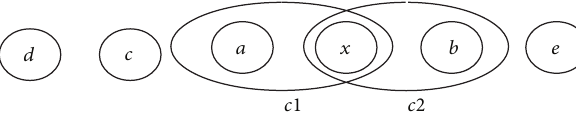
Figure 3: Node “ 𝑎 ” or “ 𝑏 ” senses the data and transmits to the base station “ 𝑥